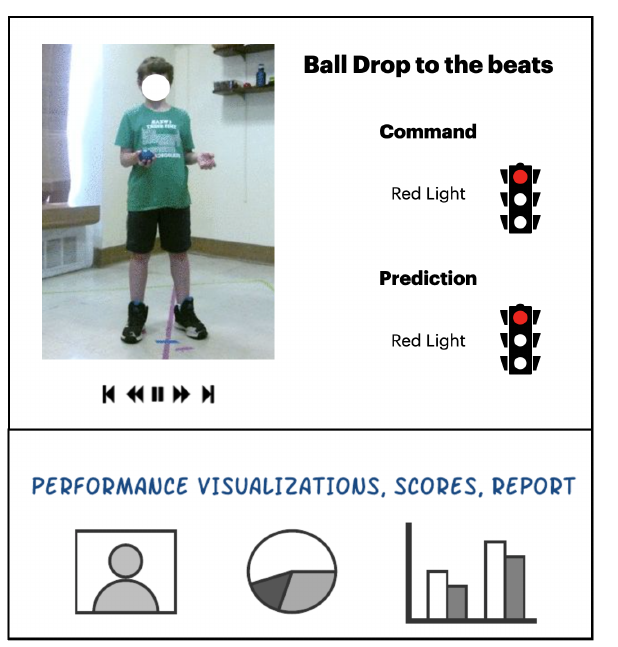
Figure 3. ATEC system